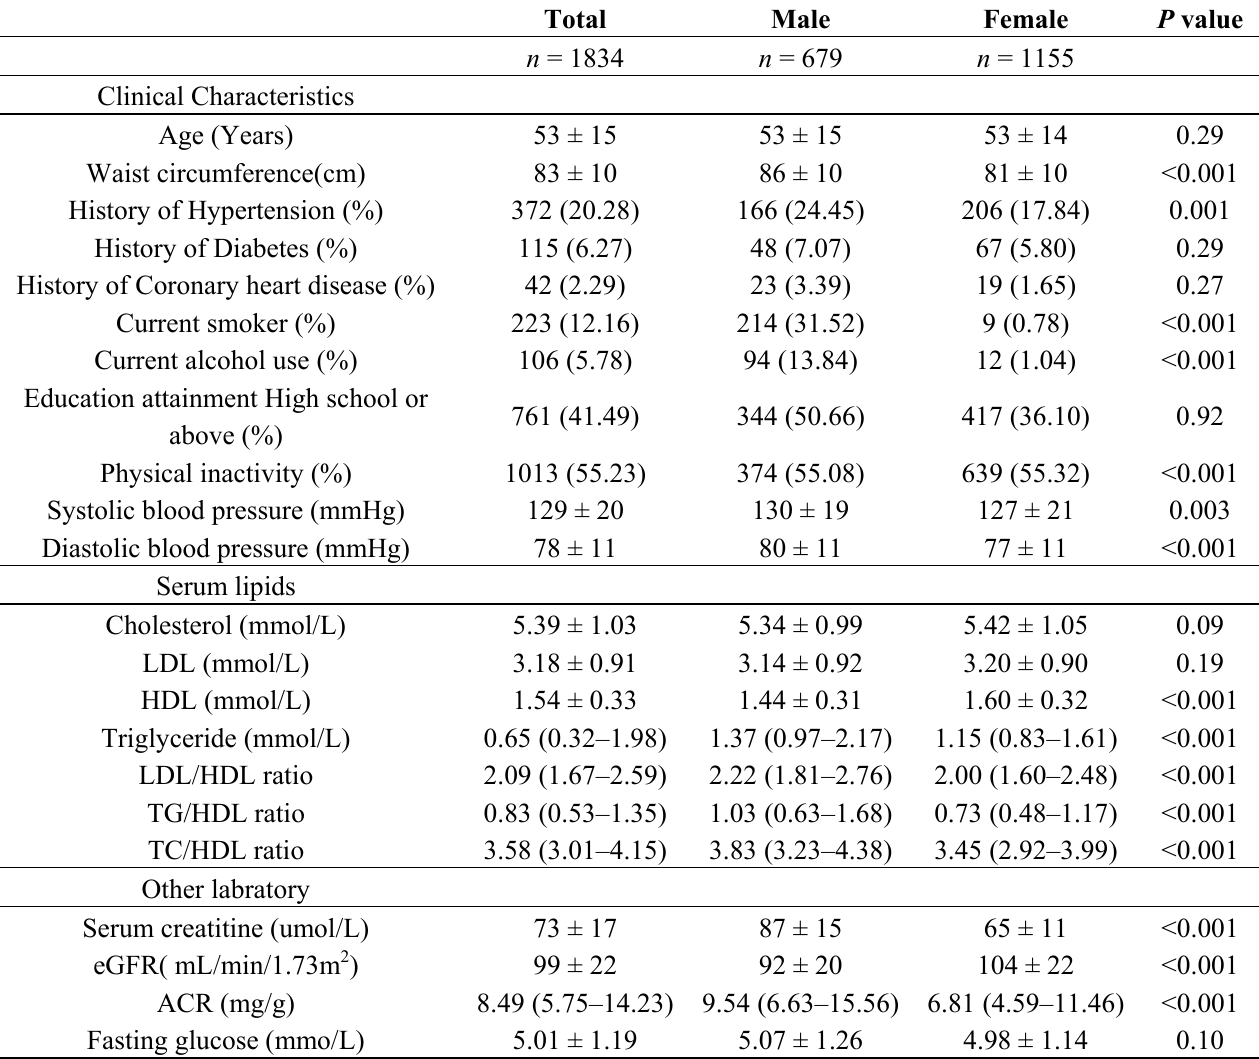
Table 1. Clinical characteristics of male and female subjects. Total